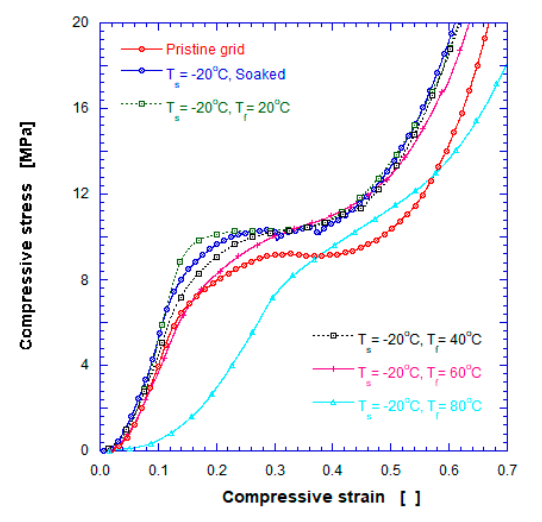
Figure 5. Compressive stress–strain curves for 3D grid structure of the copolymer.